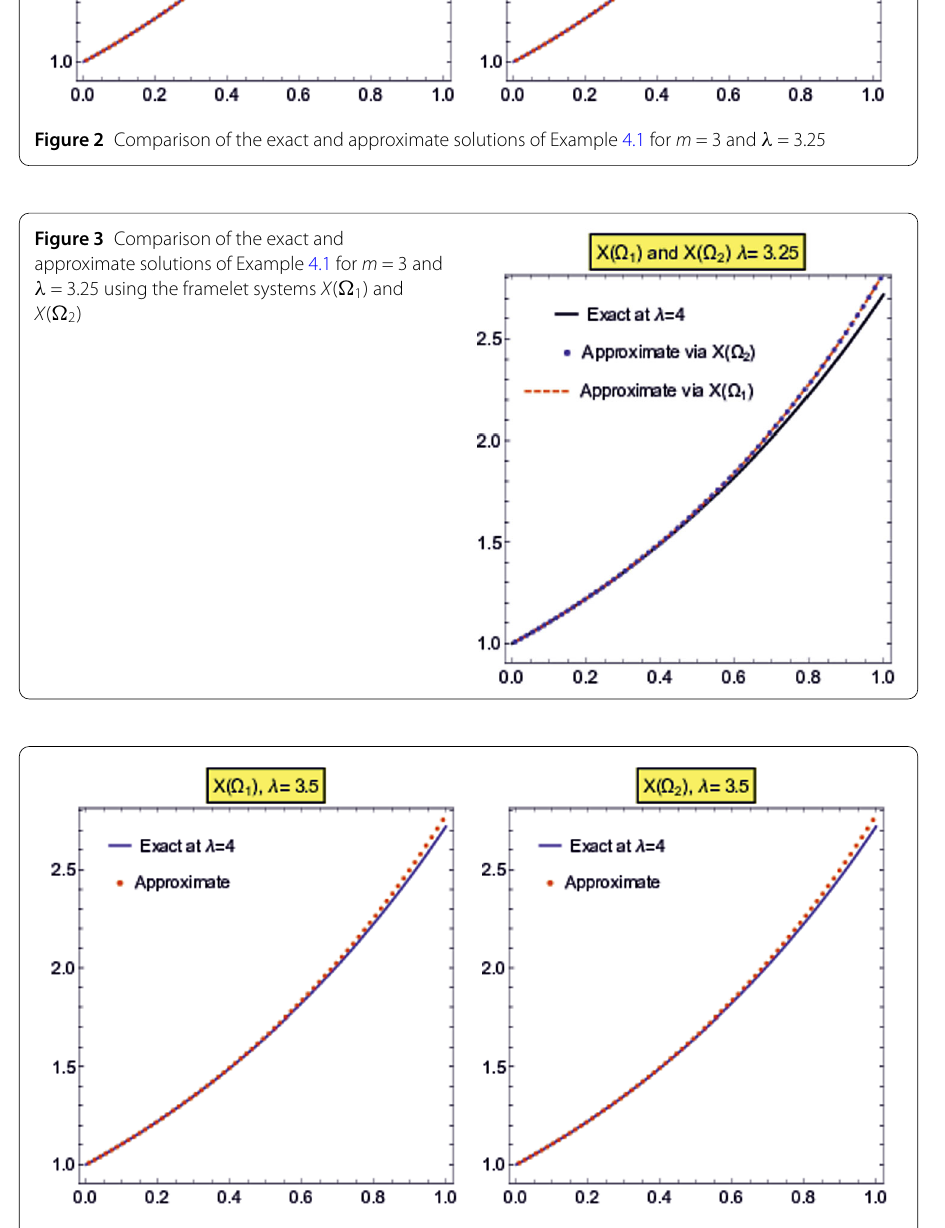
Figure 4 Comparison of the exact and approximate solutions of Example 4.1 for m = 3 and λ =